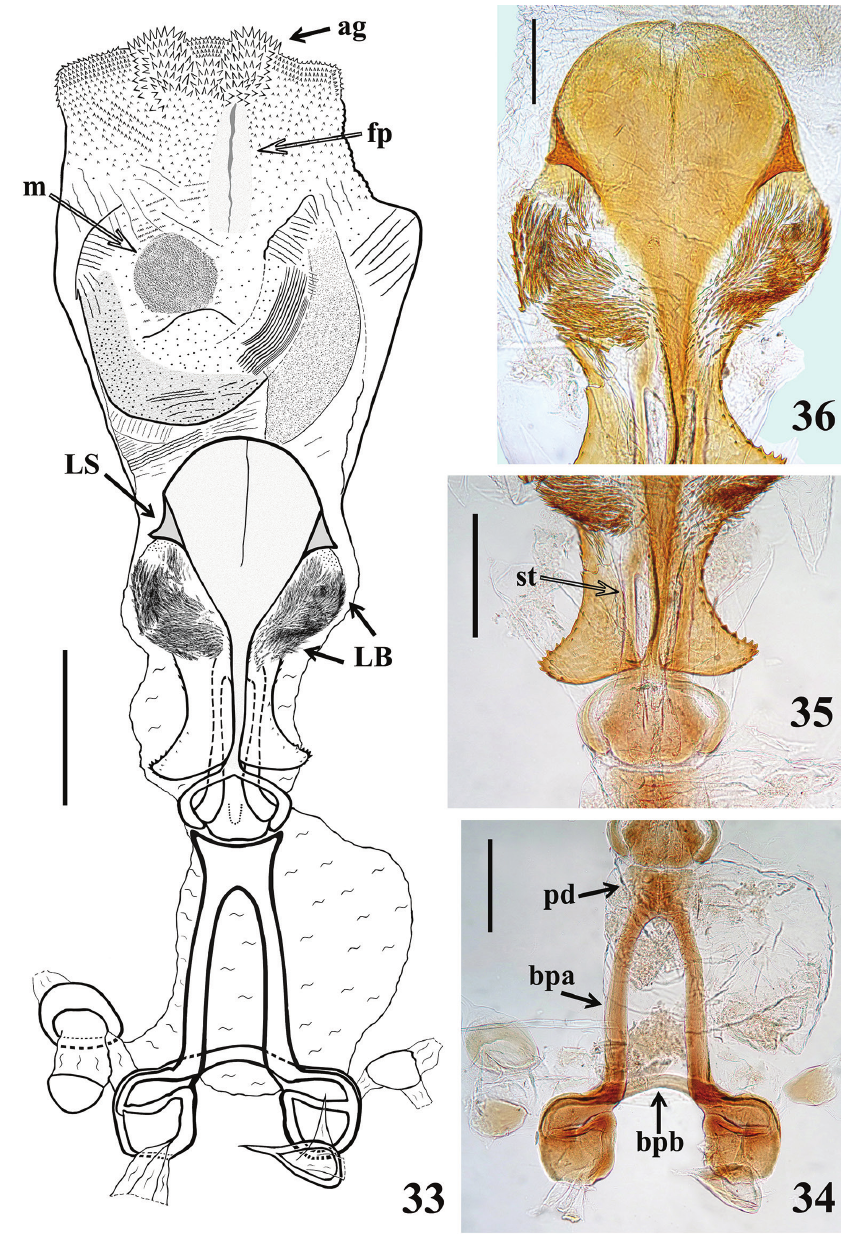
Figures 33–36. Parahiranetis salgadoi Gil-Santana, male genitalia, dorsal view. 33 phallus with expand- ed endosoma 34 articulatory apparatus 35–36 dorsal phallothecal plate and struts 35 basal portion 36 apical two-thirds. ( ag : apicolateral group of spiny processes of the endosoma; bpa : basal plate arm; bpb : basal plate bridge; fp : pair of elongate, flat processes; LB : large lobe, middle third of the phallothecal plate; LS : lateral large spine of the phallothecal plate; m : median subspherical process; pd : pedicel; st : struts). Scale bars: 0.5 mm ( 33 ); 0.3 mm ( 34–35 ); 0.2 mm ( 36